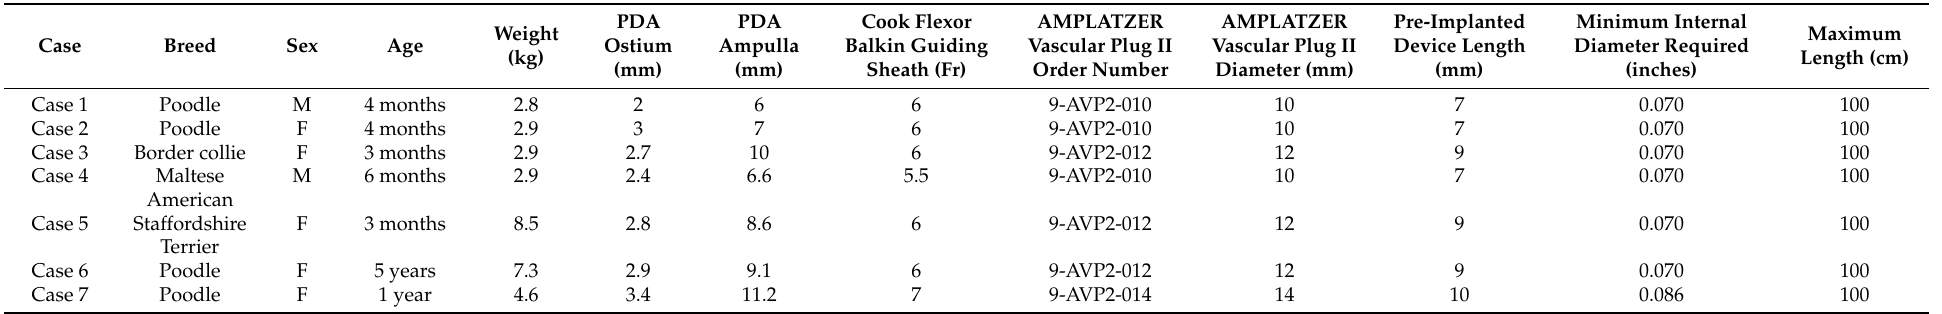
Table 1. Clinical data, minimum ductal ostium and ampulla diameters, dimension of Cook Flexor Balkin Guiding Sheath catheters at delivery, and